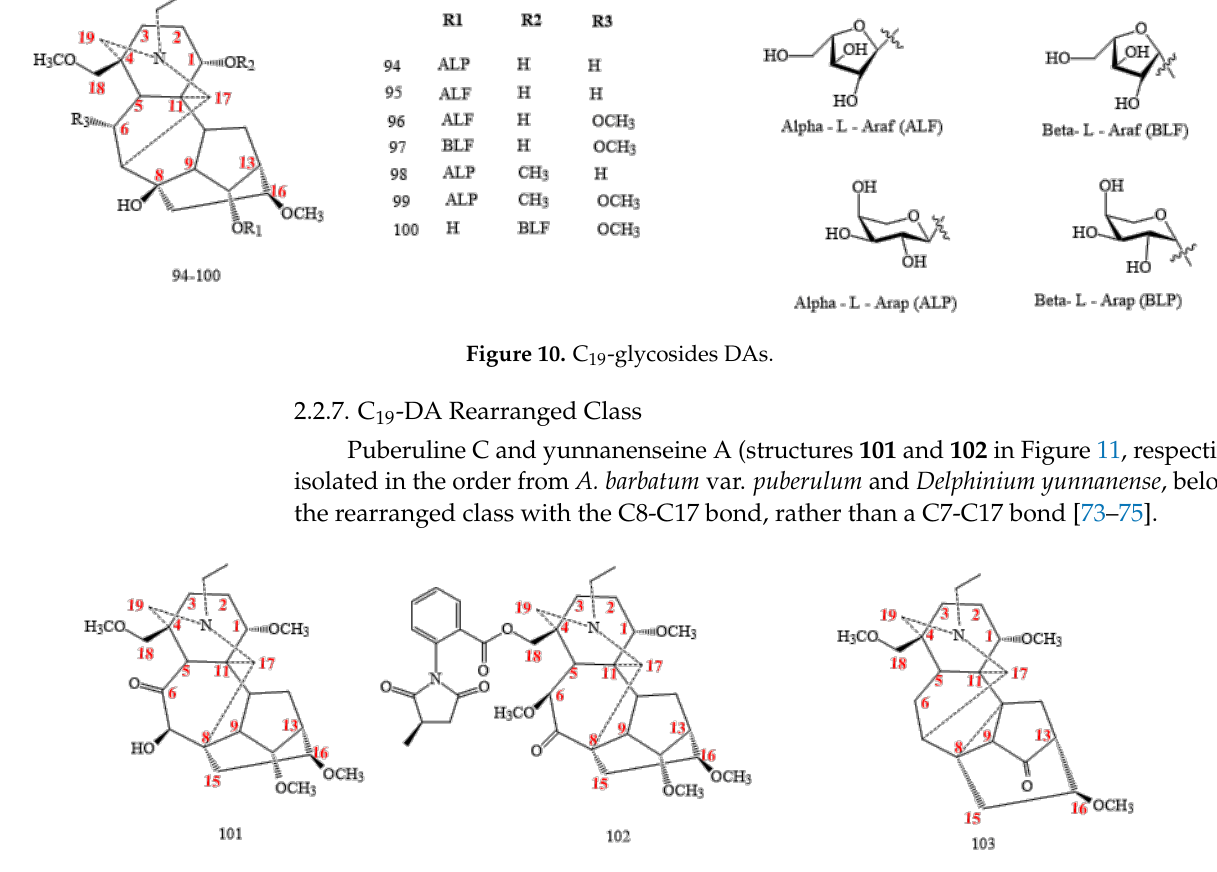
Figure 11. C 19 -rearranged DAs.